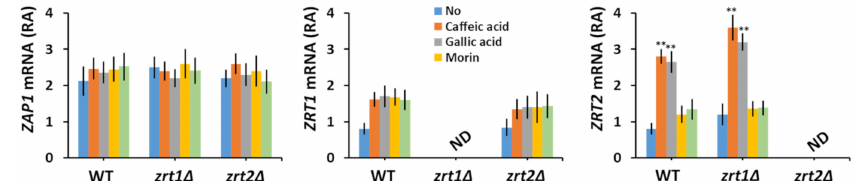
Figure 2. E ff ect of polyphenol exposure on the relative abundance (RA) of ZAP1 , ZRT1 , and ZRT2 mRNA. Exponentially growing wild type (WT), zrt1 ∆ , and zrt2 ∆ cells were inoculated (OD 600 = 0.1) in liquid minimal defined medium (MM) and grown 6 h before polyphenols were added (100 µ M concentration). Cells were incubated for 1 additional hour before RNA isolation. Analysis of transcript abundance was done by qRT-PCR as described in Section 2. Expression of ZAP1 , ZRT1 , and ZRT2 mRNA was normalized to the relative expression of ACT1 in each sample. Values are mean ± SEM of triplicate qRT-PCR-s using cDNA obtained from three distinct colonies. Two-way ANOVA; ** p < 0.01. ND, not